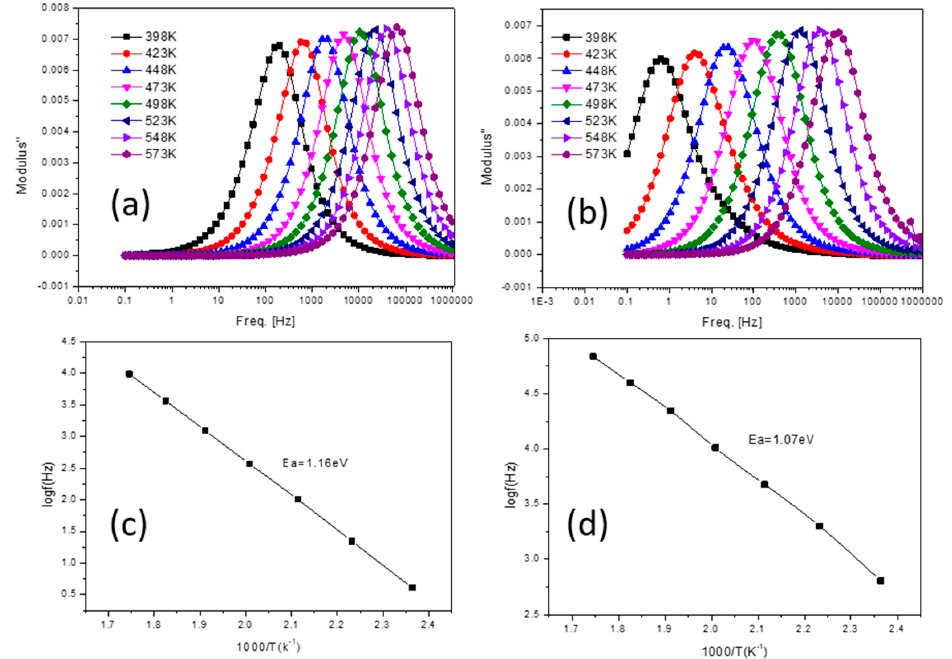
Figure 8. ( a , b ) are frequency dependence of the imaginary part of the electric modulus in the temperature range from 398 k to 573 k for Ta-LTO and LTO single crystals, respectively; and ( c , d ) are the corresponding Arrhenius plots of Ta-LTO and LTO crystals, respectively.